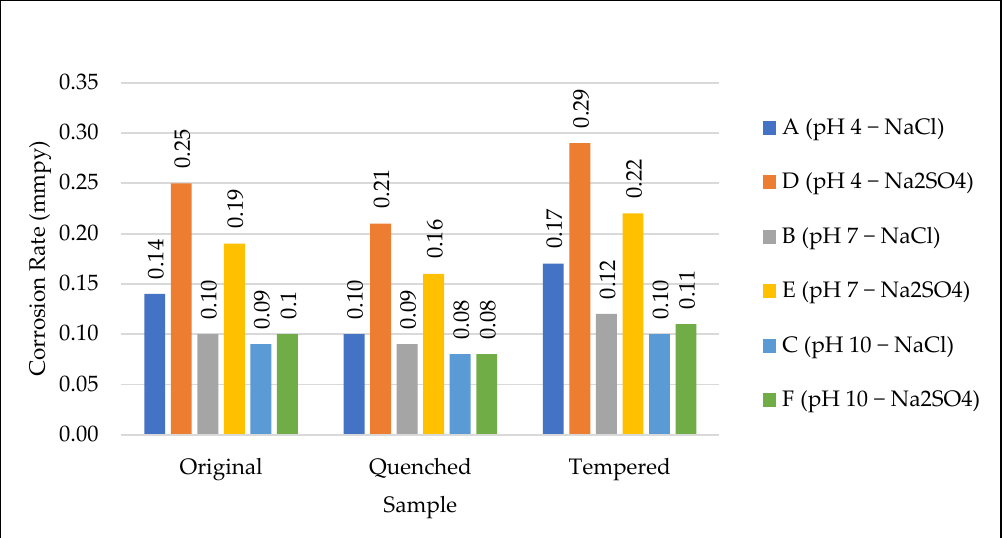
Figure 16. O, Q, and T vs. corrosion rate for NaCl and Na 2 SO 4 .